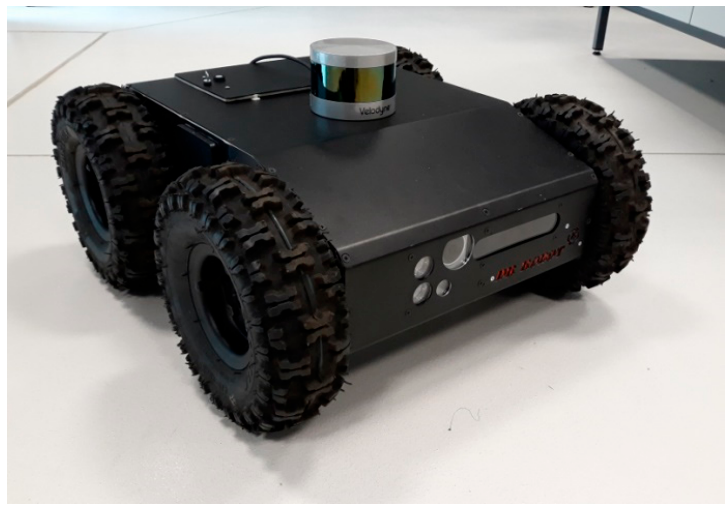
Figure 3. Mobile robotic vehicle used for tests.